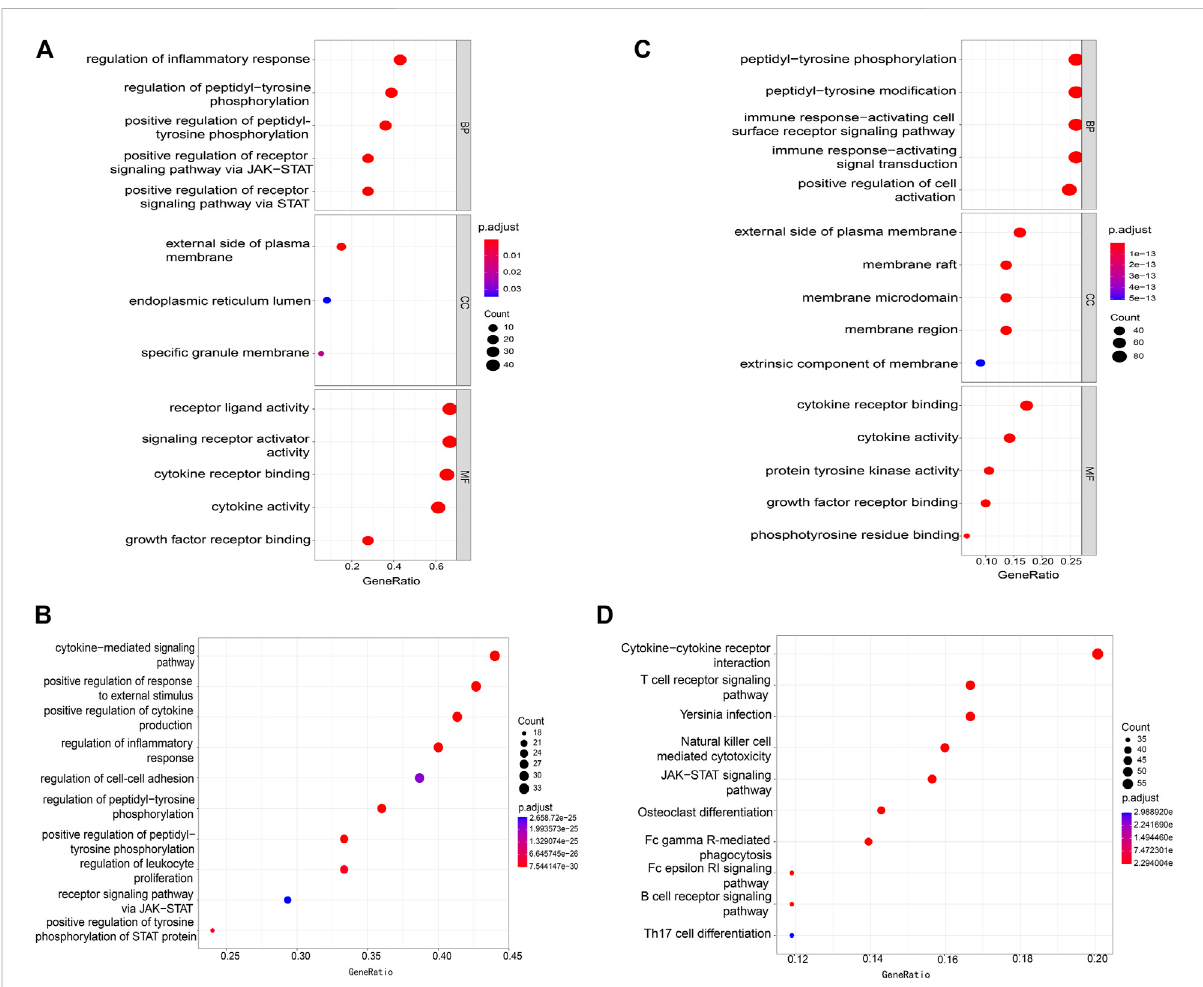
FIGURE 1 ItemsofGOandKEGGenrichmentanalysis. (A) GOanalysisforvalidatedIS-IRGs. (B) KEGGanalysisforvalidatedIS-IRGs. (C) GOanalysisforthe IS-IRG catalog. (D) KEGG analysis for the IS-IRG catalog. GO, Gene Ontology; BP, biological process; CC, cellular component; MF, molecular function; KEGG, Kyoto Encyclopedia of Genes and Genomes; IS-IRGs, ischemic stroke-immune related